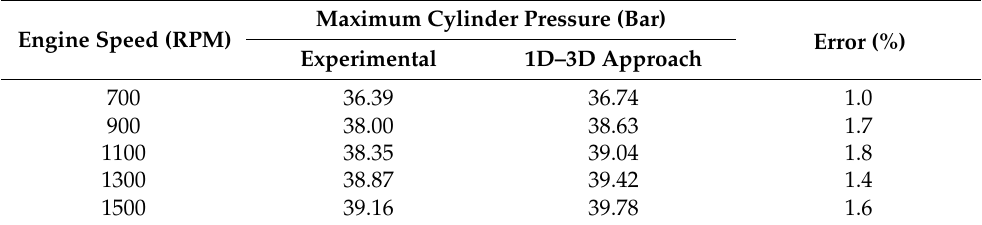
Figure 5. Cylinder pressure results of the experiment and the 1D–3D approach numerical analysis according to the engine speed. Table 2. Maximum cylinder pressure results of the experiment and the 1D–3D approach numerical analysis.